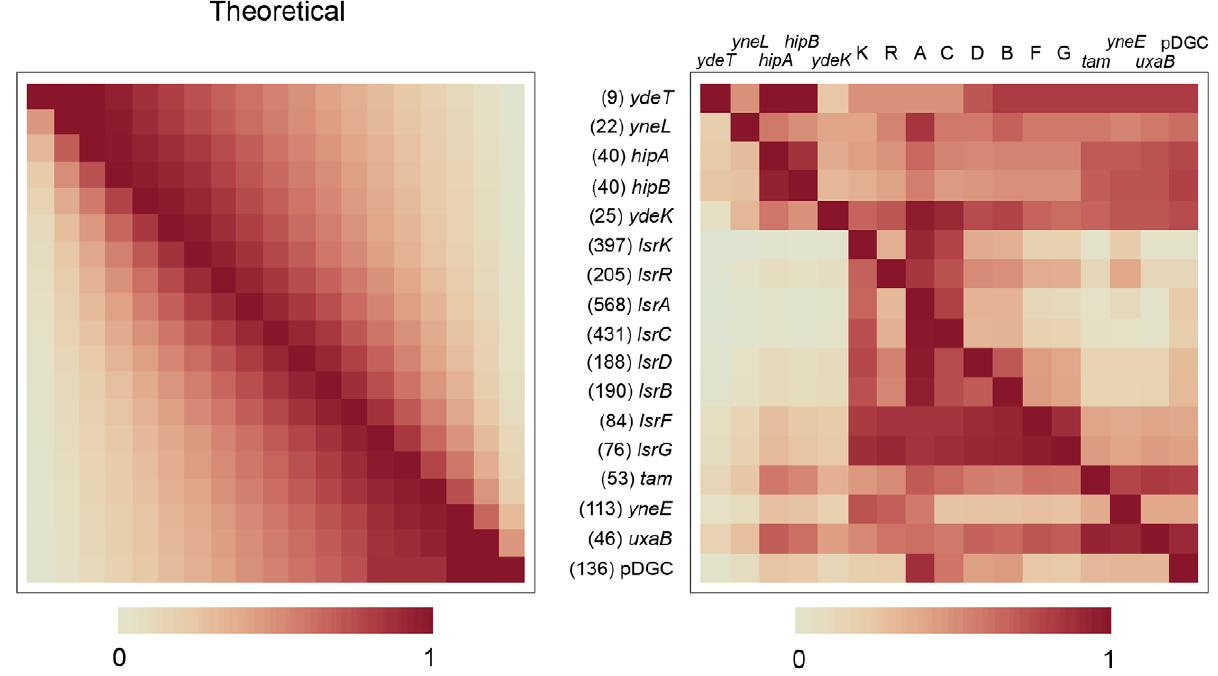
Figure 9. Coincidence matrix for E.coli Lsr system LMNAST extended window stringent search hits. Letters represent the respective Lsr genes. 1–5 represent the five genes preceding the Lsr system: ydeT , yneL , hipA , hipB , and ydeK-lipoprotein . 14–17 represent the four genes after the Lsr system: tam (transaconitate methyltransferase), yneE , uxaB , and a predicted diguanylate cyclase. The figure suggests a) strong conservation of the association between Lsr system genes relative to its neighbors, b) hits in which the Lsr system has been excised entirely from its gene neighbors, and c) a weak coincidence between yneH-glutaminase characters and the Lsr system. The matrix also indicates that the overall prevalence of lsrF and lsrG characters is lower than other canonical Lsr characters, although the presence of lsrF and lsrG characters is a good predictor of the presence of